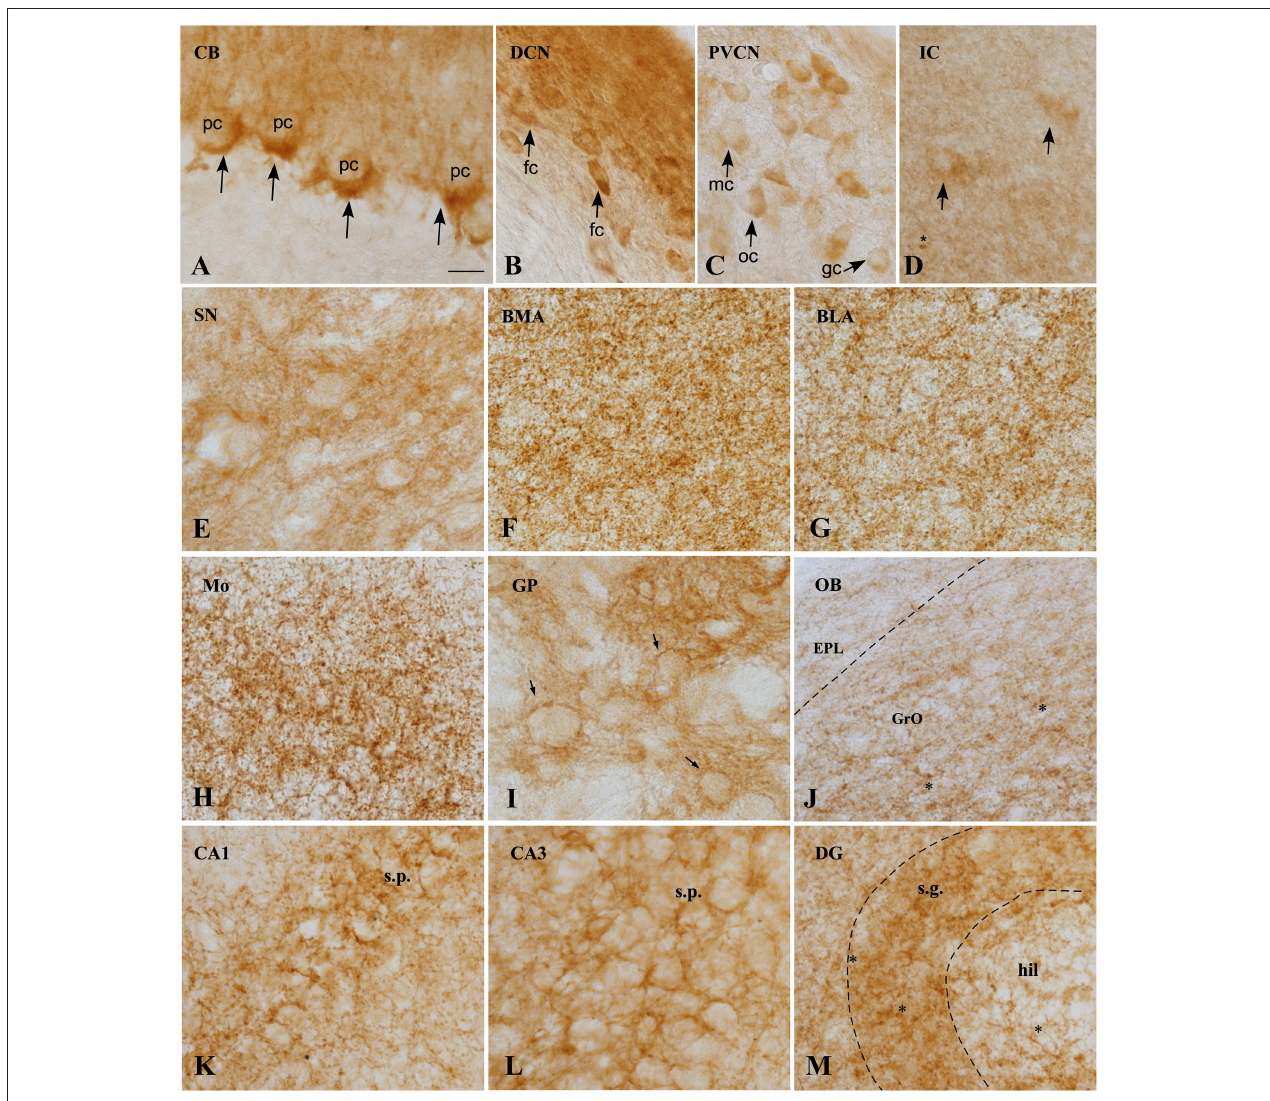
FIGURE 4 | CB1 immunoreactivity in the GASH/Sal brain . (A) Micrographs showing CB1 receptors (arrows), around the soma and the initial part of the axon of unstained Purkinje cells, constituting the so-called “Pinceaux” formation. (B) Strong and diffuse CB1 immunoreactivity in the dorsal cochear nucleus. Neurons of this nucleus appear immunostained. (C) Neurons of the posteroventral cochlear nucleus showing slight immunoreactivity for CB1R. (D) CB1 expression in the central nucleus of the inferior colliculos, exhibiting diffuse immunoreactivity. Scarce medium-size neurons appears labeled intracelularlly. Asterix indicate small immunoreactive glial cells. (E) CB1 immunoreactivity is observed in not strong delineate fibers in the substantia nigra. (F,G) CB1R immunostaining in the basomedial (BML) and basolateral (BLA) amygdala, showing the neuropil granular/reticular staining. Labeling is slightly weaker in BLA. (H) Strong CB1 immunoreactive fibers with a plexiform pattern in the motor cortex. (I) High CB1 expression in the globus pallidus, where a strong network of immunoreactive fibers surround immunonegative-traversing fascicles (arrows). (J) CB1 immunoreactivity of the Olfactory bulb, exhibiting moderate immunoreactivity of Granule cell layer (GrO) and weakly immunoreactivity of the external plexiform layer (EPL). Asterisk indicates small immunoreactive glial cells. (K–M) . CB1 expression in rat hippocampal formation. CB1 positive fibers surround the somata of pyramidal cells in CA1 (K) and CA3 (L) fields of the hippocampus. Numerous varicosities, corresponding to terminals is apparent. Receptor levels are particularly high in the granule cell layer (sratum granulosum) of the dentate gyrus. Scale bar = 20 µ m for all panels. BLA, Basolateral amygdala nucleus; BMA, Basomedial amygdala nucleus; CA1–3, Cornu Ammonis area 1–3 CB, Cerebellum; DCN, Dorsal cochlear nucleus, DG, Dentate gyrus; fc, Fusiform cells; EPL, External plexiform layer olfactory bulb gc, Globular cells; GP, Globus pallidus; GrO, Granule cell layer olfactory bulb; hil, Hilus; IC, Inferior colliculus; mc, Multipolar cells; Mo, Motor cortex; OB, Olfactory bulb; oc, Octopus cells; pc, Purkinje cells; PVCN, Ventral cochlear nucleus, posterior part; SN, Substantia nigra; s.g., Stratum granulosum; s.p., Stratum